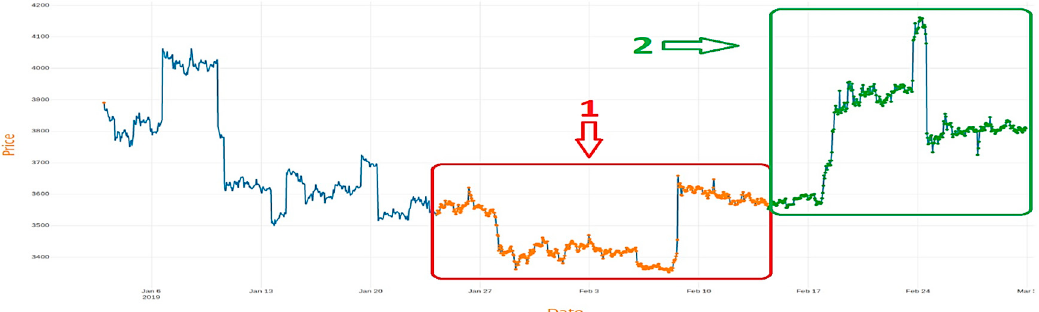
Figure 8. The result trading process that tested after 450-time training, where “buy” action matched the first square, “sell” in the second square.